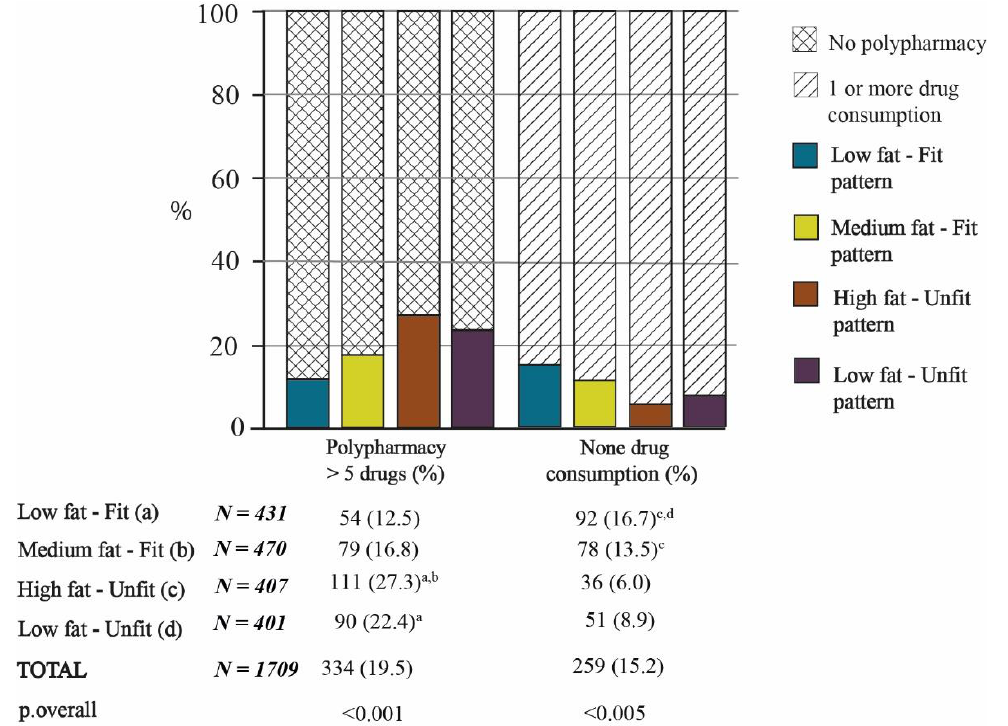
Figure 2. Prevalence of polypharmacy and of lack of drug consumption according to the Fat–Fit patterns. Note: The statistical significance of the proportions between groups can be observed in the columns. The letters in superscript indicate the bilateral comparisons that are significantly different ( p < 0.05).